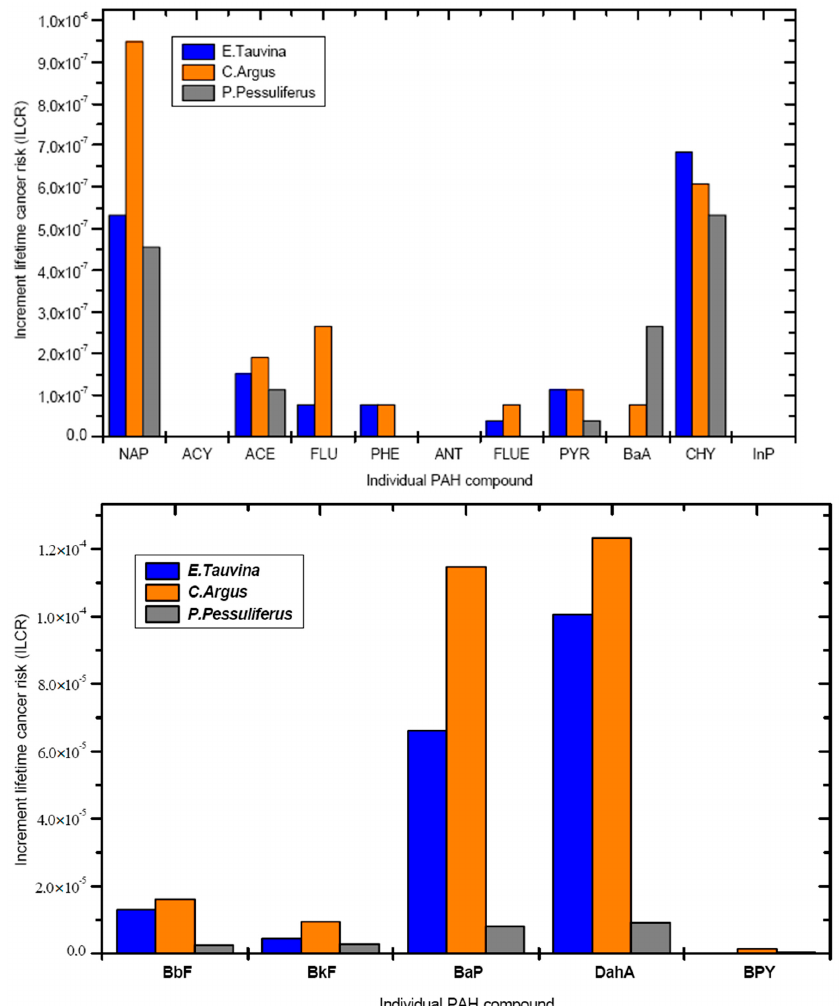
Figure 3. Incremental lifetime cancer risk (ILCR) of the individual PAH compound concentrations for three endemic fish of Jeddah.